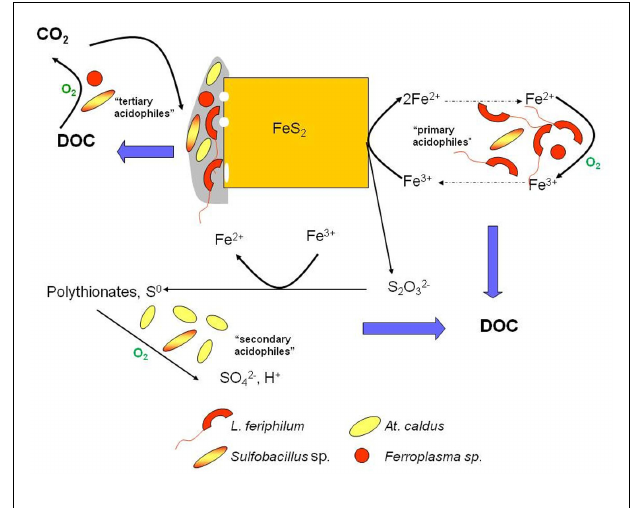
FIGURE 7 |The oxidative dissolution of pyrite in acidic liquors, showing the major microorganisms identified in the biooxidation of refractory gold concentrates and the bioleaching of a cobaltiferous pyrite concentrate processed at ca . 40˚C. Those reactions that consume oxygen are indicated; “DOC” is dissolved organic